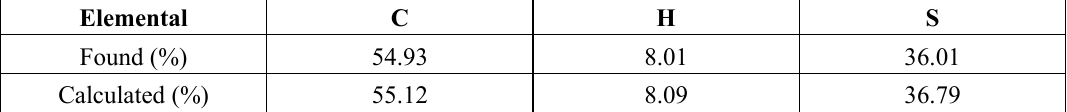
Table 2. The elemental analysis results of 1,2-bis(2-methylallyl)disulfane.